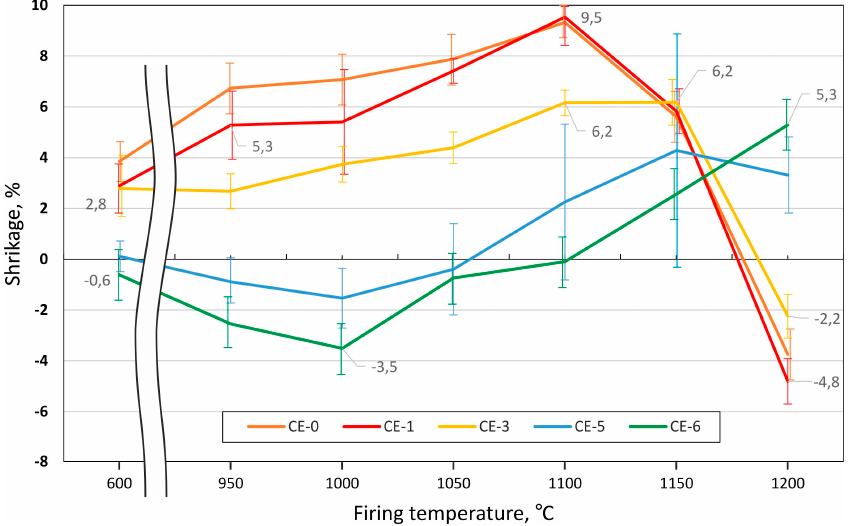
Figure 2. Dependence of total shrinkage on CS content and firing temperature.